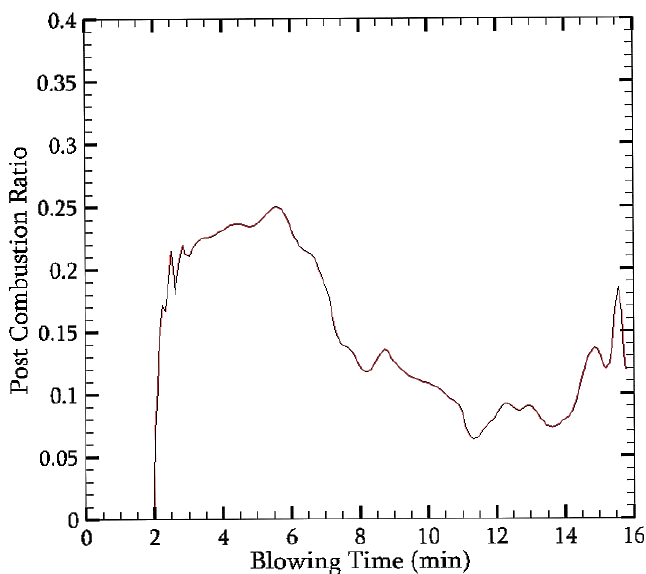
Figure A1. Post combustion ratio profile considered for the calculation.